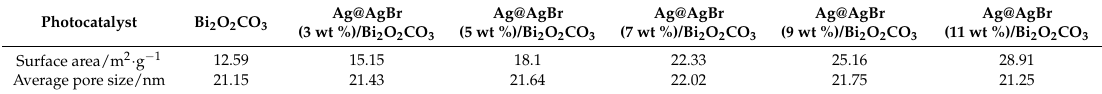
Table 1. Specific surface areas and average pore size of the prepared samples.